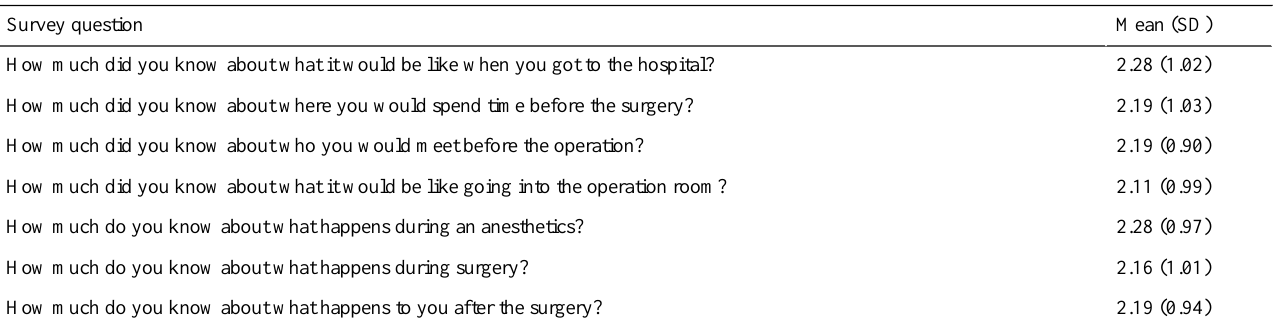
Table 2. Children’s average ratings of how much they knew about the hospital visit on the day of the procedure (4-point scale, ranging from 1=“nothing at all” to 4=“a lot or